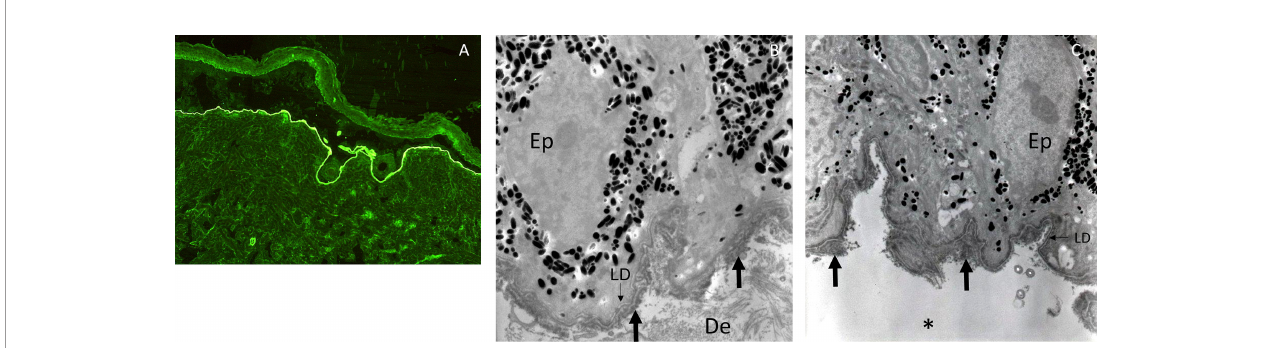
FIGURE 1 | Immune deposits in indirect immuno fl uorescence microscopy on salt-split skin and in direct immunoelectron microscopy in a patient with MMP with anti-type VII collagen reactivity. Indirect immuno fl uorescence microscopy on primate salt-split skin showing a labeling of the fl oor of the cleavage by the serum of a patient with MMP with anti-type VII collagen reactivity (A) . Direct immunoelectron microscopy in a patient with MMP with anti-type VII collagen reactivity showing thick IgG (B) and C3 (C) deposits (large arrows) in the anchoring fi bril zone below the lamina densa (LD, thin arrows) and split (asterisk) below them (Ep, epidermis; De,